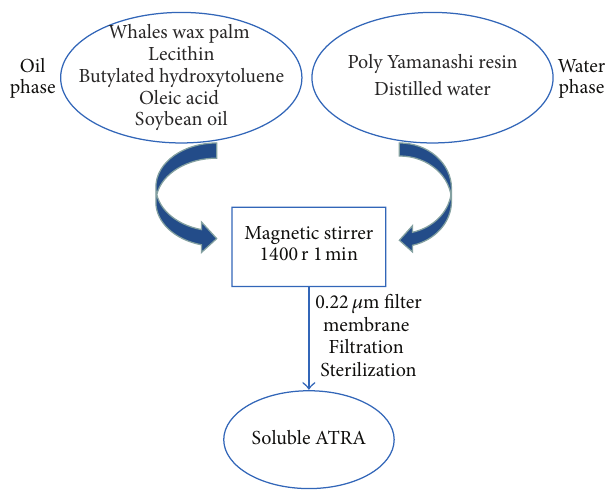
Figure 1: The method used to prepare